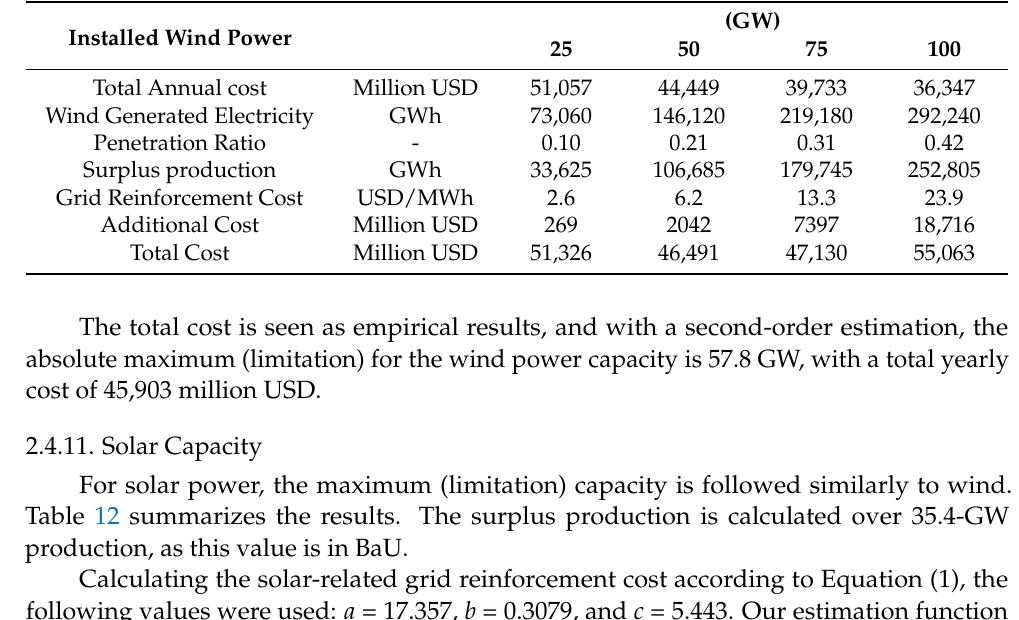
Table 11. Variation of the total cost for the wind capacity with the addition of the grid integration cost.